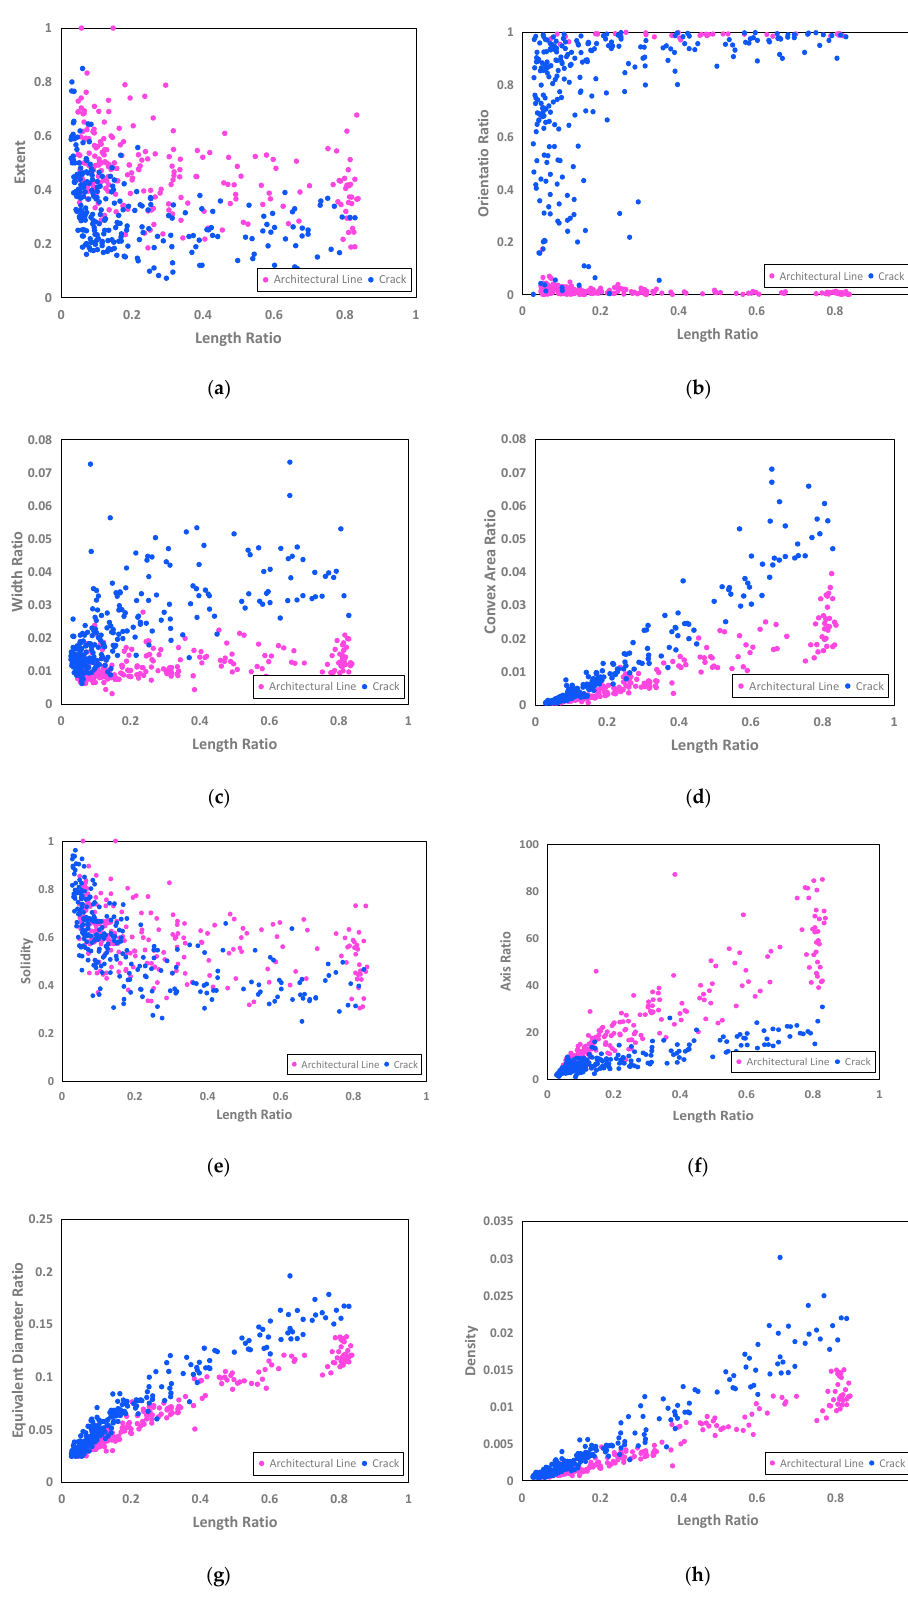
Figure 9. The results of the connected component analysis. ( a ) Extent ‐ length ratio, ( b ) orientation ratio ‐ length ratio, ( c ) width ratio ‐ length ratio, ( d ) convex area ratio ‐ length ratio, ( e ) solidity ‐ length ratio, ( f ) axis ratio ‐ length ratio, ( g ) equivalent diameter ratio ‐ length ratio and ( h ) density ‐ length ratio.